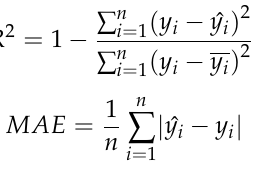
Figure 3. ARIMA fitting effect. It can be seen that the ARIMA model has a good fitting effect on the number of con- firmed cases in China recently, but the trend prediction of the model shows a certain lag. Given the good model fitting effect, the ARIMA model can predict the recent epidemic situation in China, which has important scientific guiding significance for epidemic pre- vention and control. Due to the time lag in the trend prediction of the model, a certain prediction error is caused. As shown in Table 1, MSE = 4681.444, RMSE = 68.421, MAPE = 0.217, R 2 = 0.814,